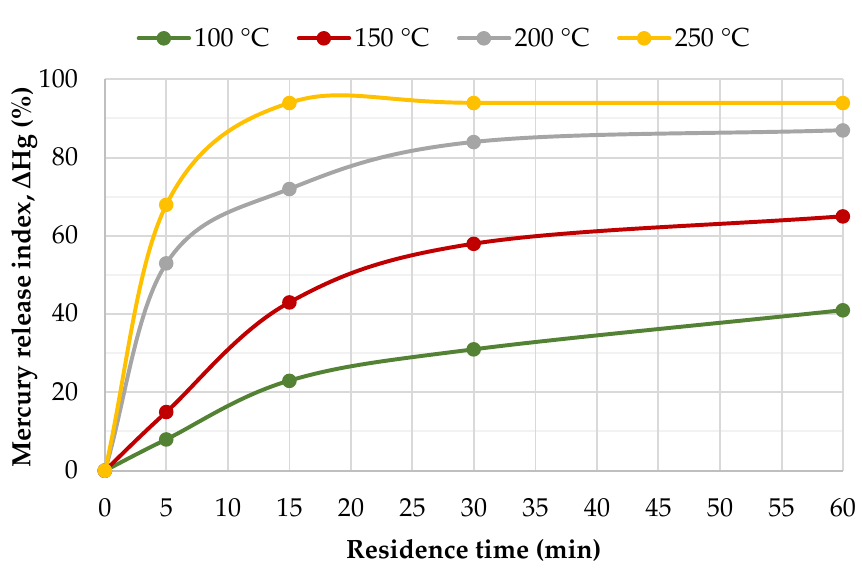
Figure 3. Effect of residence time at final temperature on the release of mercury from Sample RDF-1 (purge gas flow: 500 cm 3 /min).